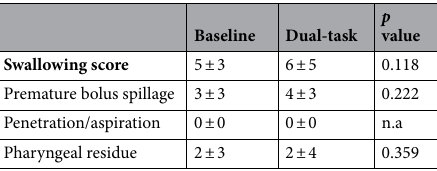
Table 1. Comparison of the swallowing score and its subdomains between single-task and cognitive dual- task conditions. Mean value ± SD of the swallowing score and its subdomains during single task condition and during cognitive dual-task condition with the p value of the post-hoc comparison. n.a . not applicable.